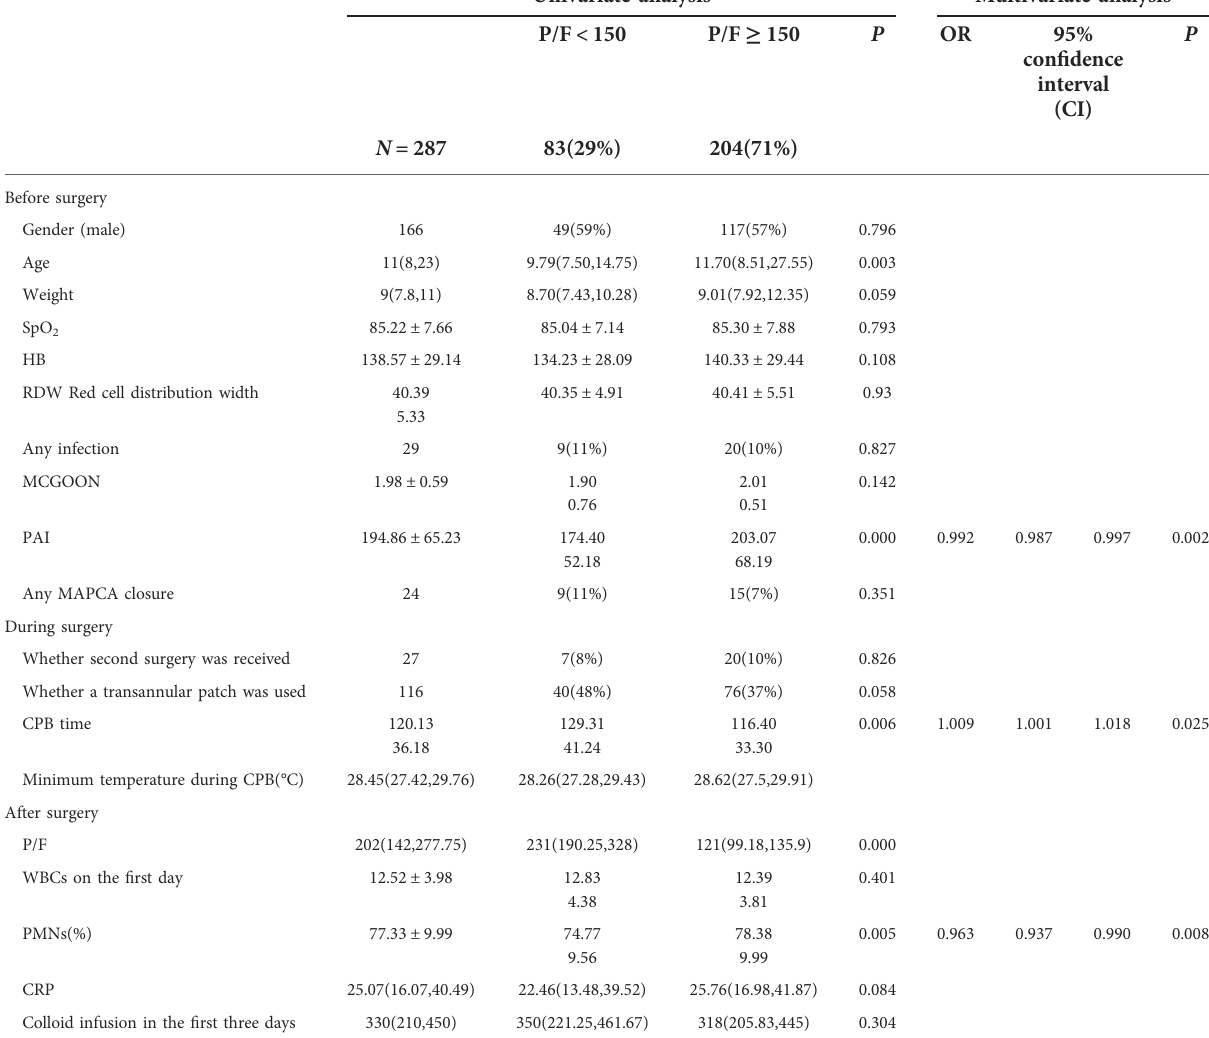
TABLE 1 Analysis of risk factors for SLI group and routine group after TOF